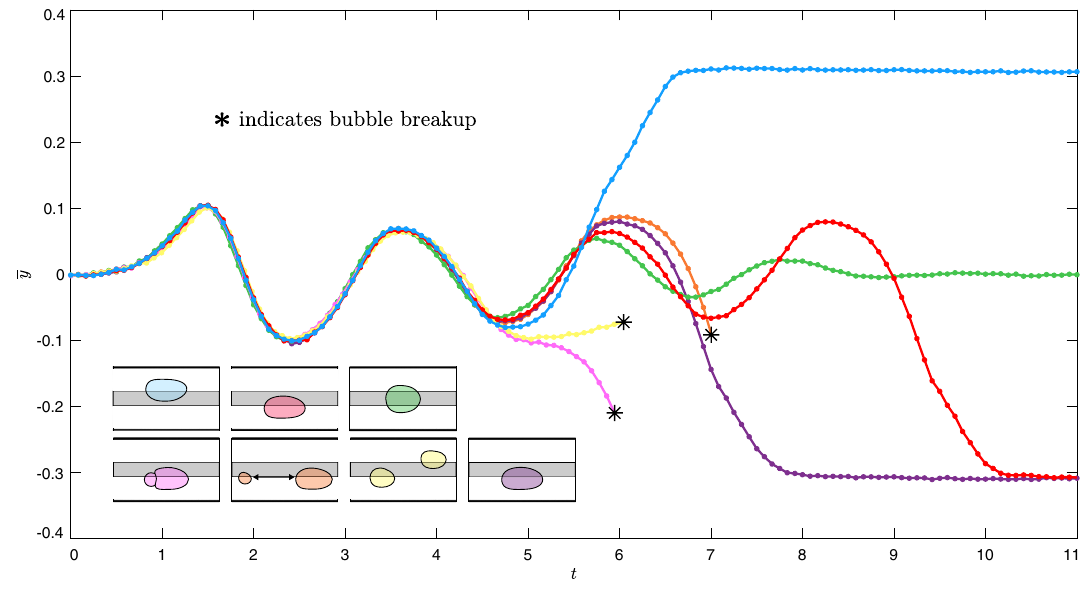
Figure 3. Time-evolution of the bubble centroid lateral offset, denoted y , for each bubble in Fig. 2a,b and an additional (purple-coloured) bubble which evolves towards off-rail propagation on the bottom of the rail. The first peak and trough of each curve correspond to the bubble’s circumvention of the obstacle. Insets: final states of the bubbles.